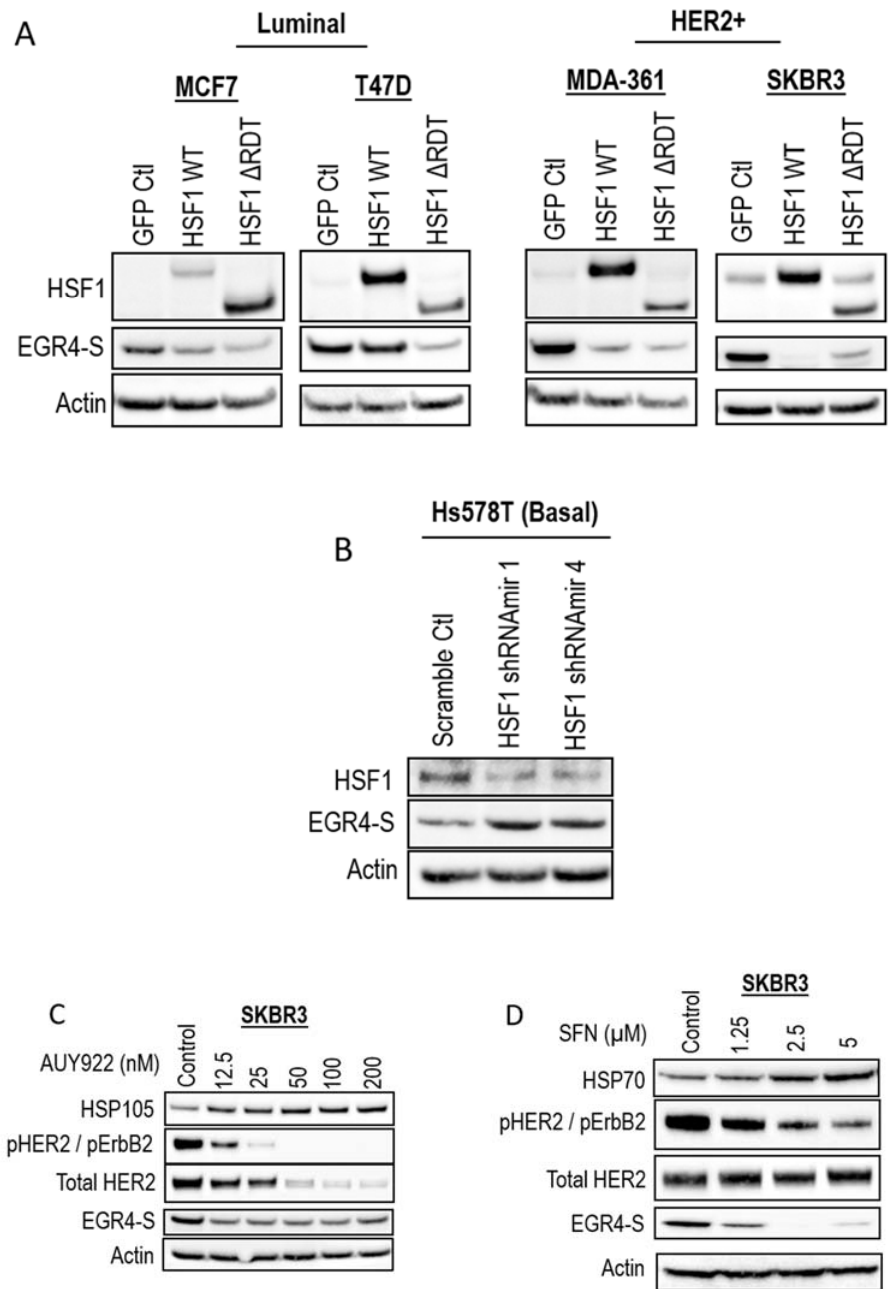
Figure 4. Inverse association between HSF1 and EGR4-S expression. Western blots for EGR4-S and HSF1 expression in ( A ) Luminal, HER2+, and ( B ) Basal breast cancer cells, with overexpression or shRNA-knockdown of HSF1, respectively. ( C ) Western blots of HER2+ cells treated with varying concentrations of the stress-inducing compound, AUY922, for 24 h and ( D ) sulforaphane (SFN) for 24 h.